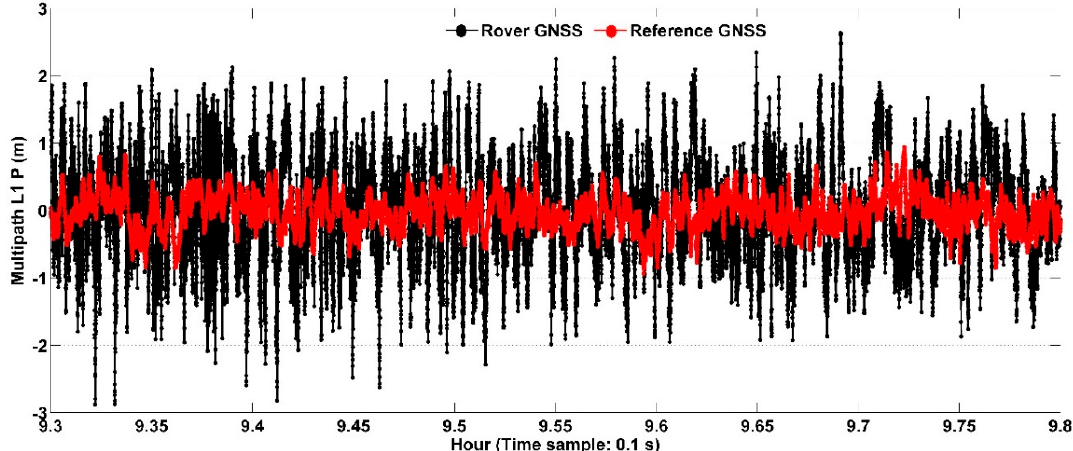
Figure 6. L1 Multipath superimposed time series of Satellite G16 for rover (black) and base station (red).